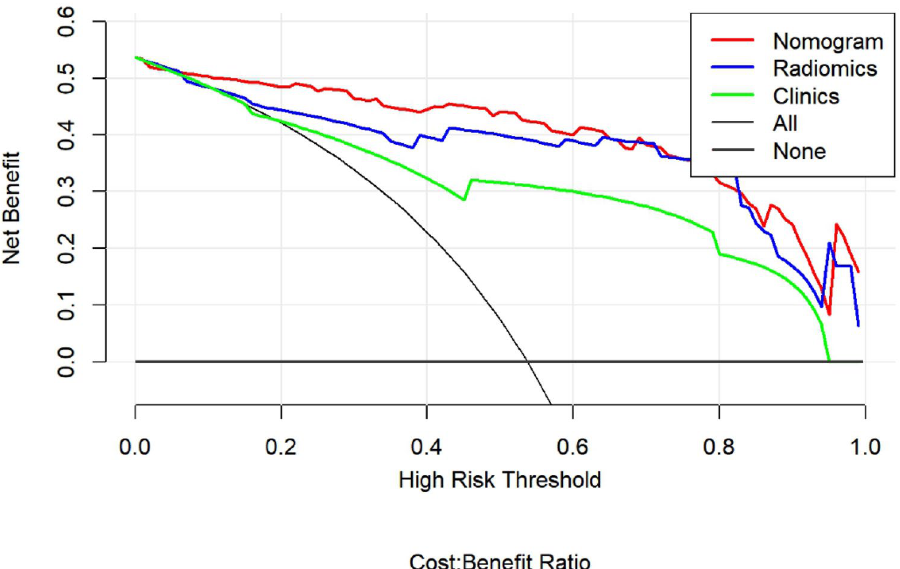
Figure 6. Decision curve analysis of imaging and clinicopathological features. The green, blue and red lines correspond to the nomograms from the clinical, radiomic, and nomogram models, respectively. Also, the light gray line is associated with the hypothesis that all imaging and clinicopathological features are related to ovarian malignant tumors. As well, the dark gray line is associated with the hypothesis that all imaging and clinicopathological features are not related to ovarian malignant